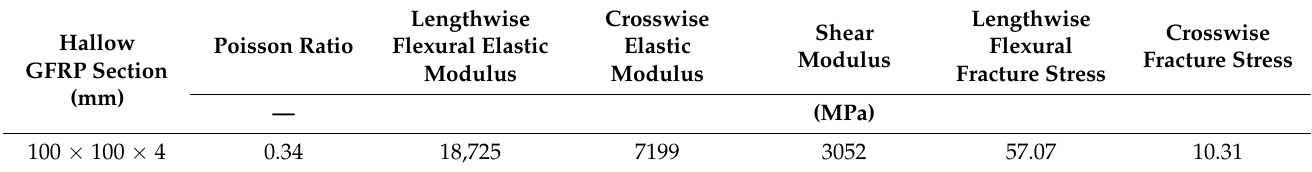
Table 2. Flexural properties of GFRP material for numerical modelling [28].